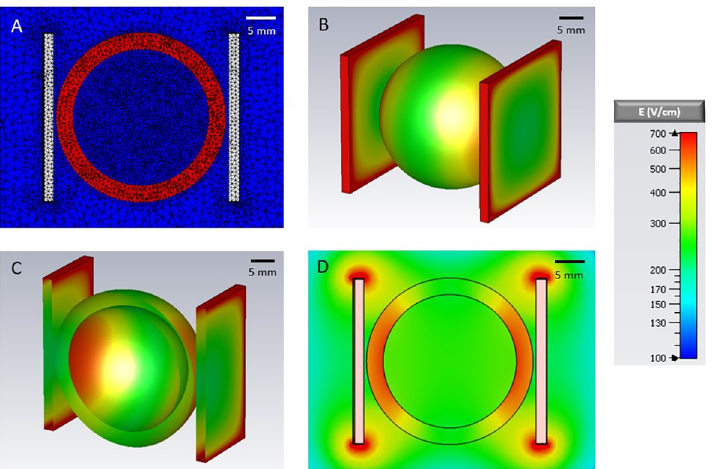
Fig 2. Electric field distribution for a voltage of 1 kV applied to two parallel plate electrodes (separation 2.8 cm) positioned on either side of a simplified heart model. A) 2D mesh view of the xz-plane B) 3D view of the closed cardiac shell model C) The model cut open along the xz-plane and D) 2D view of the